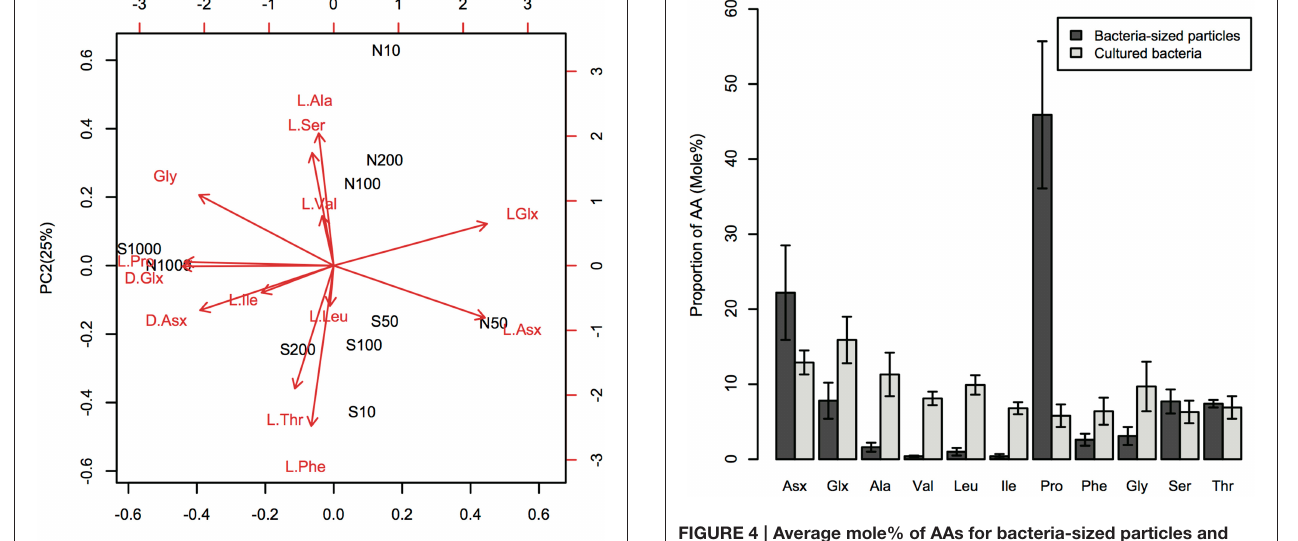
FIGURE 4 | Average mole% of AAs for bacteria-sized particles and nine strains of cultured bacteria. Errors are standard deviations. AA abbreviations are the same as in Figure 2 . For the details of cultured bacterial strains, see the legend of Figure 5